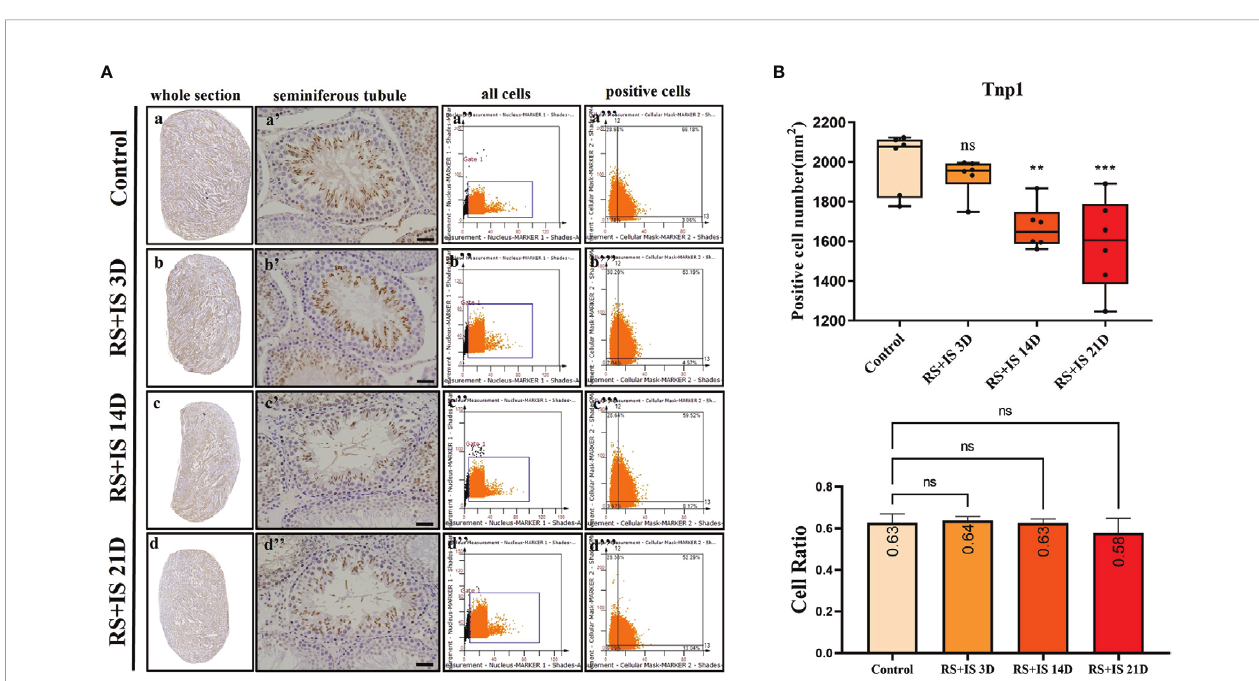
FIGURE 8 | (A) IHC expression of Tnp1. (a – d) show the section of testis. (a ’– d ’ ) show the seminiferous tubule (Bars = 50 m m). (a ’’– d ’’ ) positive points represent all cells. (a ’’’– d ’’’ ) all the positive points in right upper quadrant represent the positive cells. (B) Box plot shows Tnp1 (upper)-positive cell counting number; each point represents one section. Bar plot (lower) shows Tnp1-positive cell ratio (positive cell counting/all cell counting), n = 6. Values with different superscripts indicate signi fi cant differences between control and treatment groups on one-way ANOVA (* P < 0.05, ** P < 0.01, *** P < 0.001). ns, non-signi fi